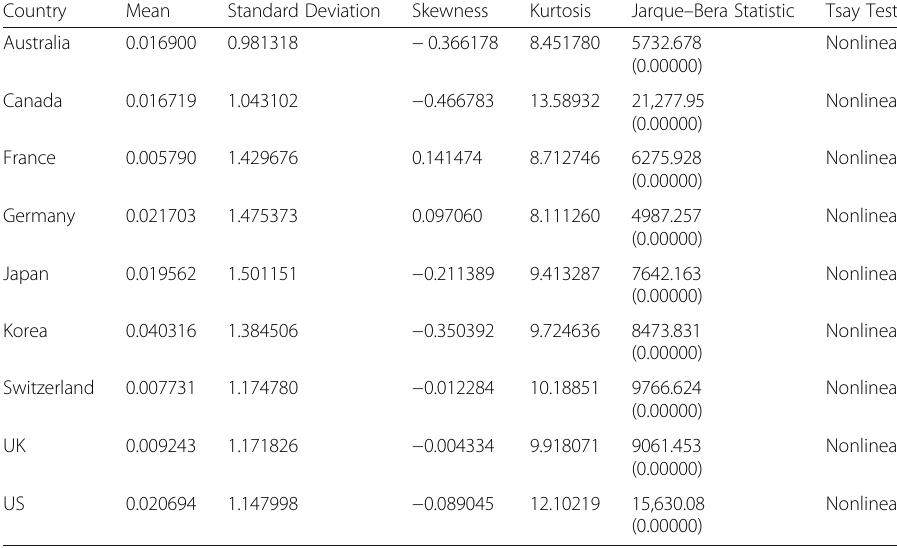
Table 1 Descriptive Statistics for Developed Markets